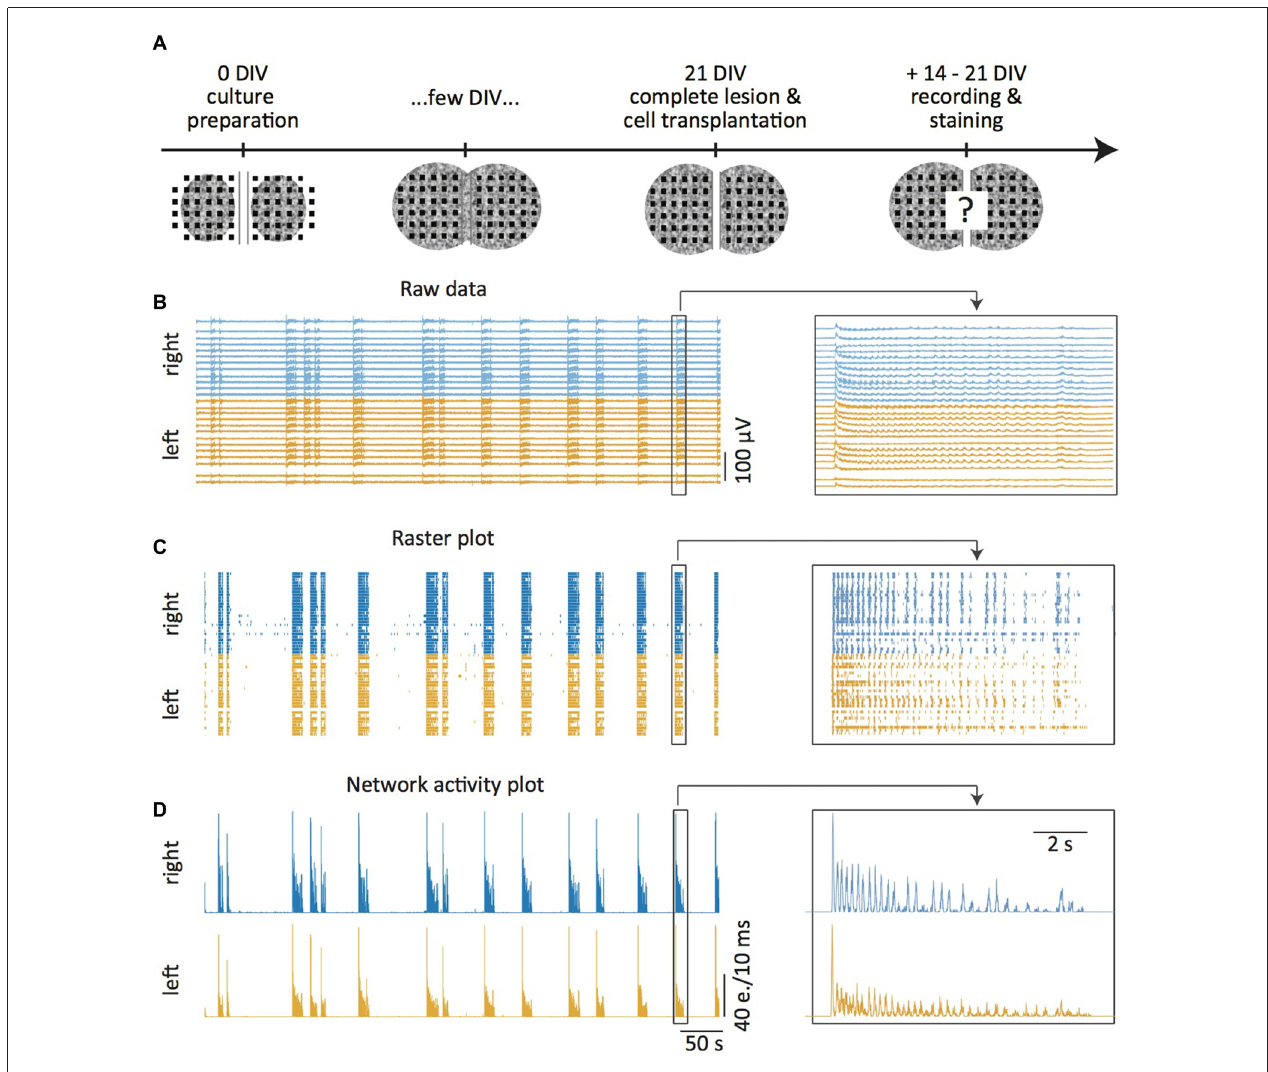
FIGURE 1 | Experimental setup. (A) In vitro model: two spinal cord (SC) slices are placed on both sides of a 300 µ m wide central groove on a multi-electrode array (MEA) at days in vitro 0 (DIV0). Within a few days, newly outgrowing axons connect the two slices. At DIV21 the newly generated connections are transected with a scalpel and embryonic cells grafted into the lesion site. Two to three weeks later the slice activity is measured, the tissue fixed and immunohistochemically stained. (B–D) MEA recordings 14–21 DIV after slice transection. Raw data under disinhibition ( B , 10 µ M gabazine and 1 µ M strychnine) and offline detected neuronal activity displayed as time markers (“events”) in a raster plot (C) . Network activity plots representing total activity ( D , e. = events). The magnification on the right shows a burst pair. The “left” and “right” refer to the left and right slices on the